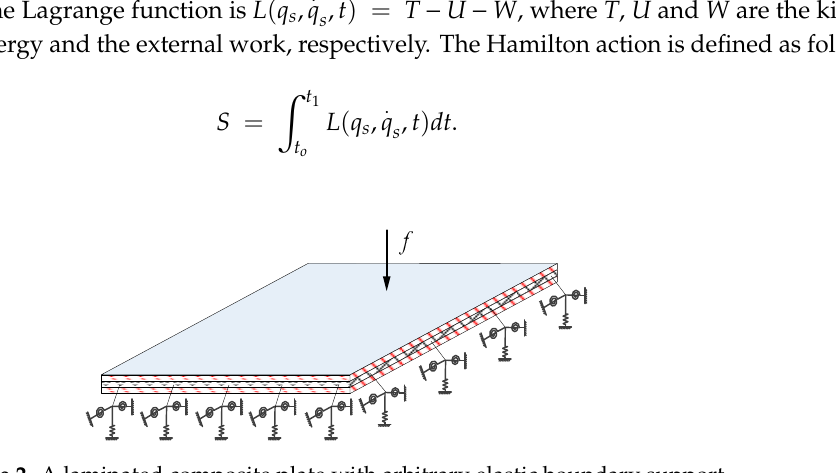
Figure 2. A laminated composite plate with arbitrary elastic boundary support.